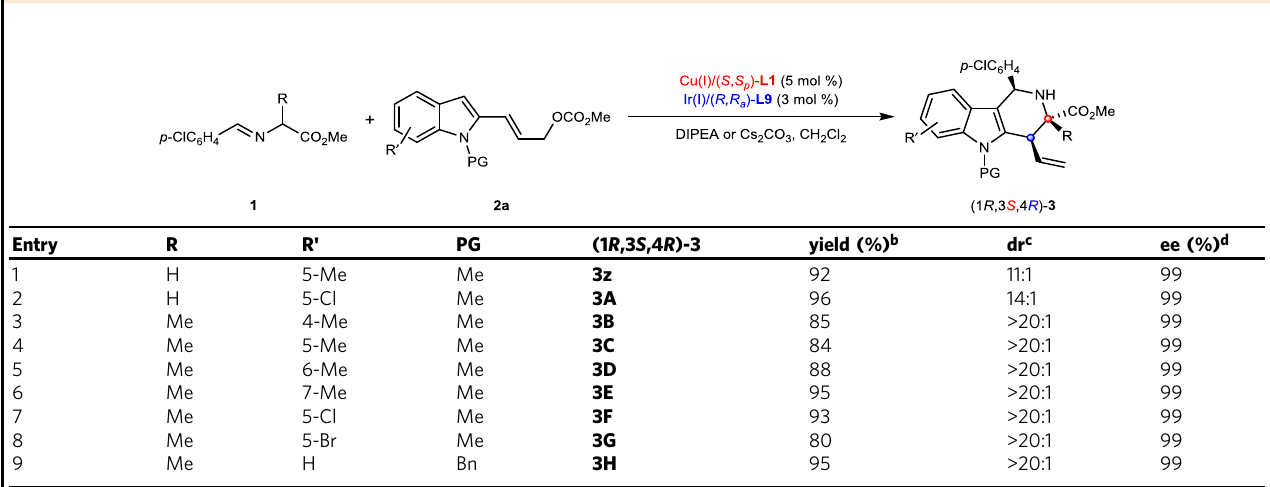
Table 3 Substrate scope of 2-indolyl alyl carbonates a